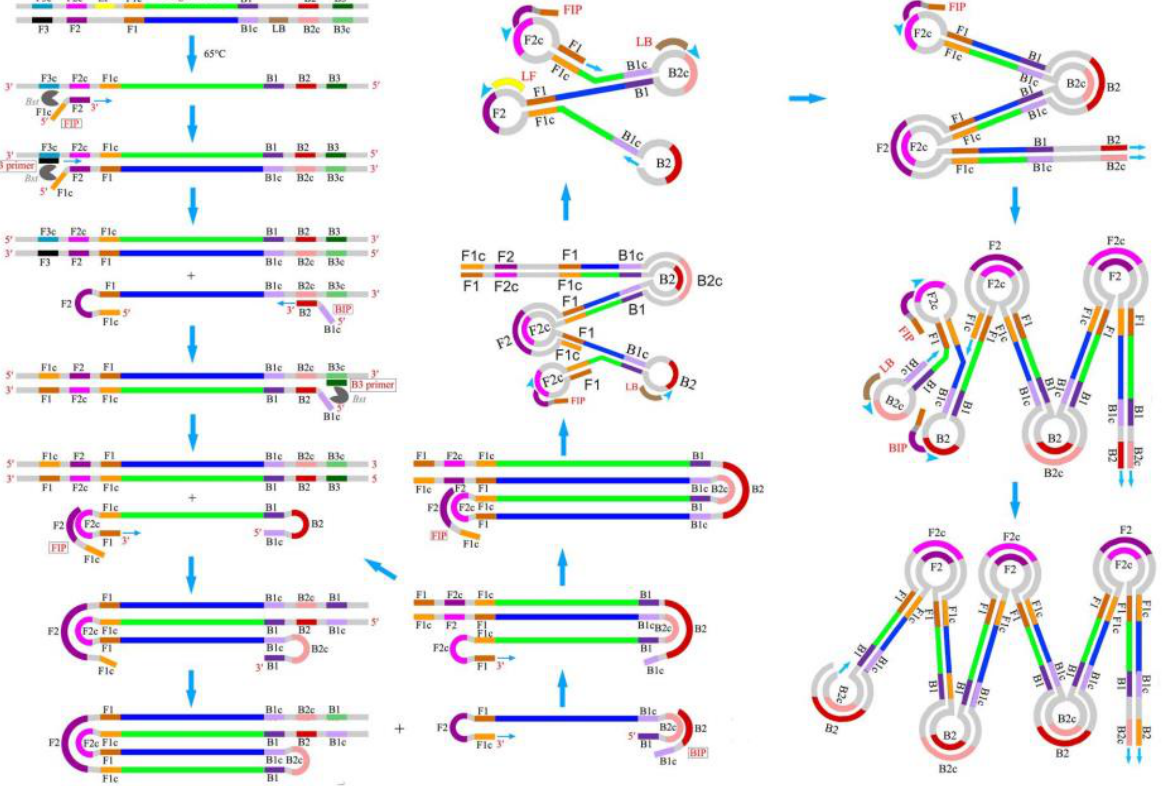
Figure 2. Schematic of LAMP [33]. (Copyright 2016 Li, Xiong, Liu, Liang and Zhou).